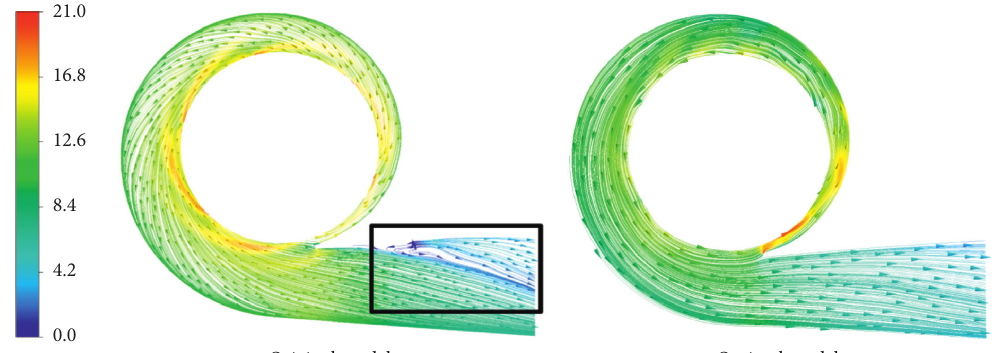
Figure 21: Velocity and streamline distribution at 1.2 Q